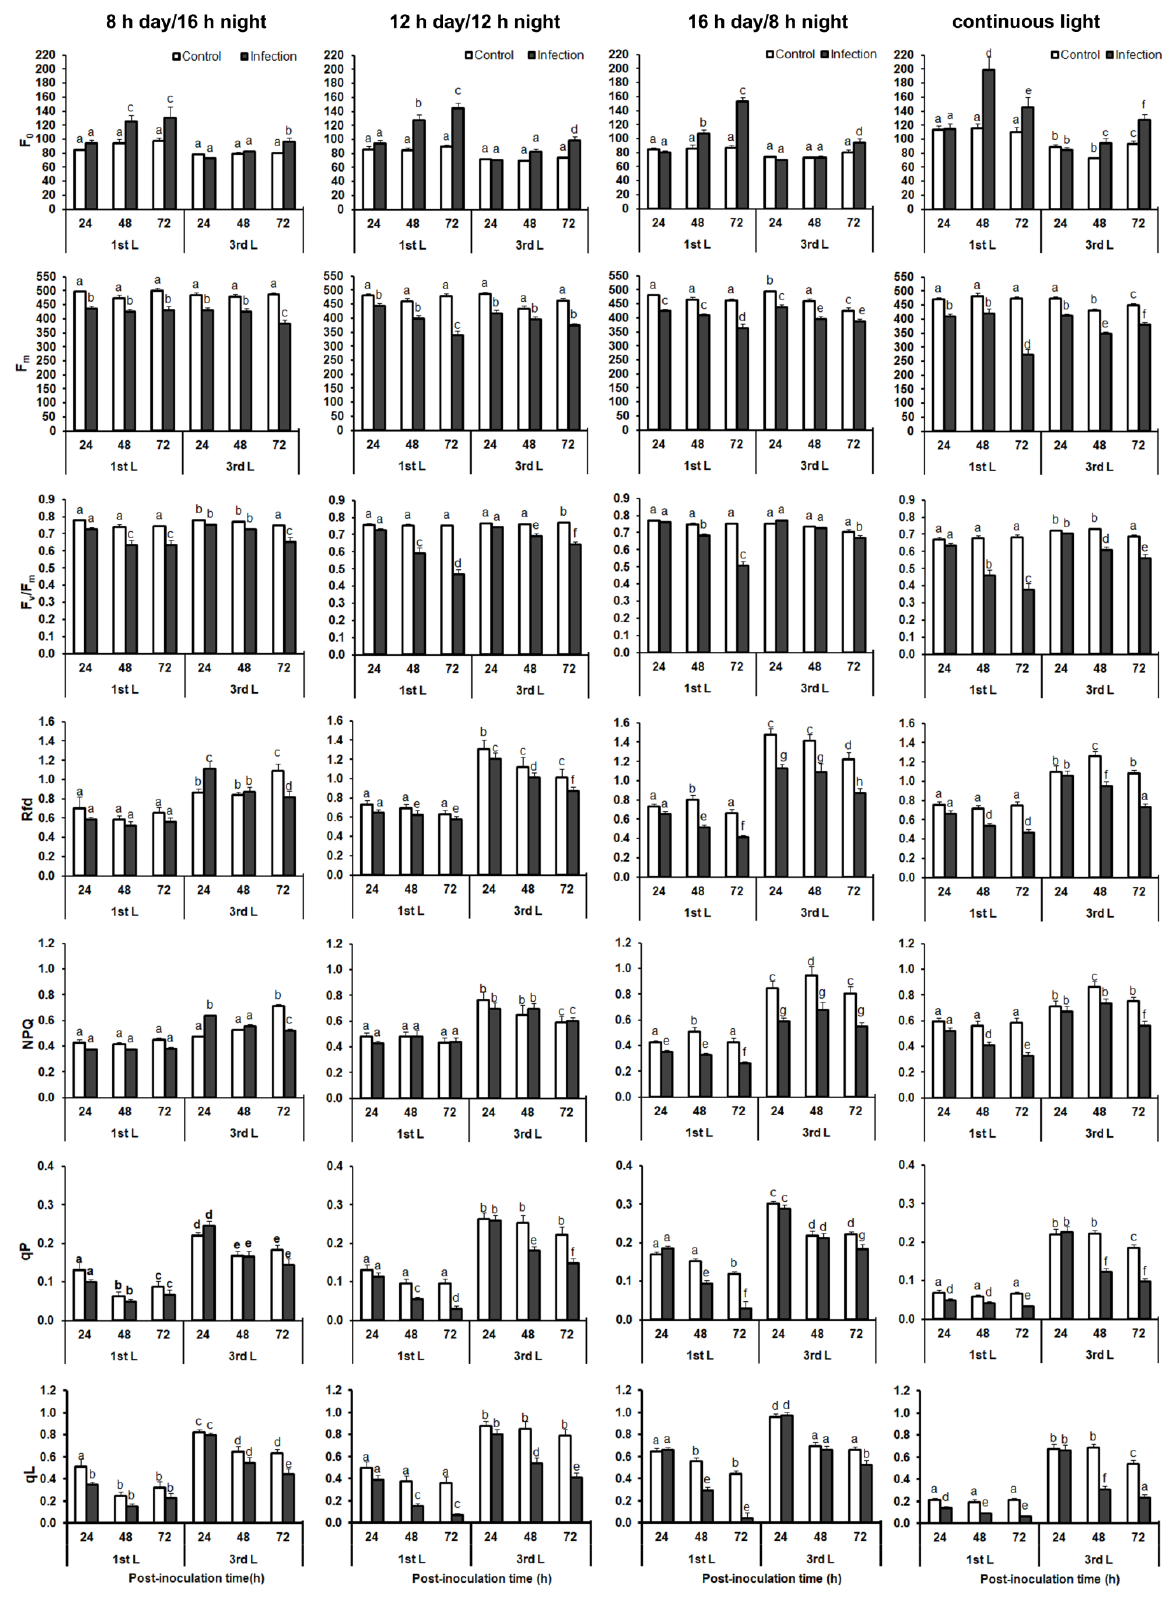
Figure 5. Time-course changes in chlorophyll a fluorescence of B. juncea 1st and 3rd leaves in response to A. brassicicola infection. Plants were grown and infected under different day-length regimes simultaneously. The mean values ± SE